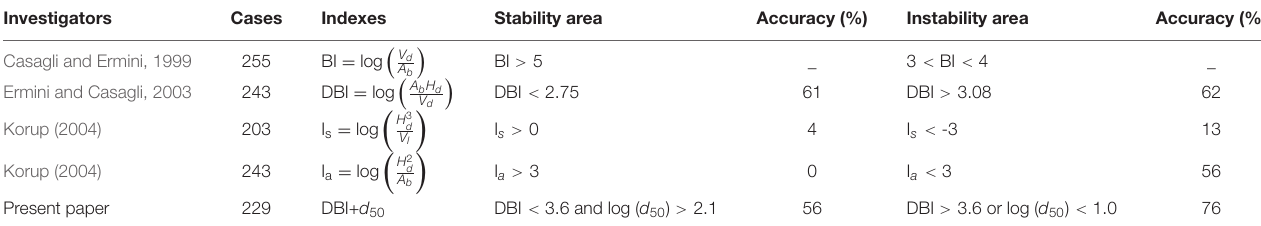
TABLE 2 | Evaluation indexes for landslide dam